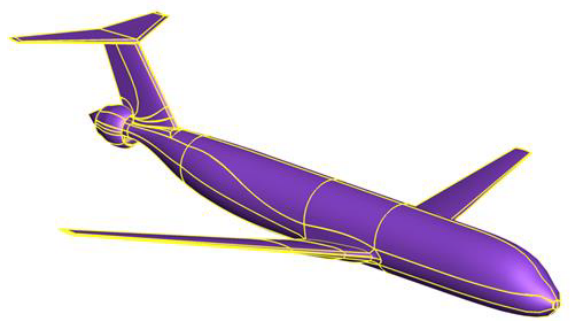
Figure 1. Aircraft configuration